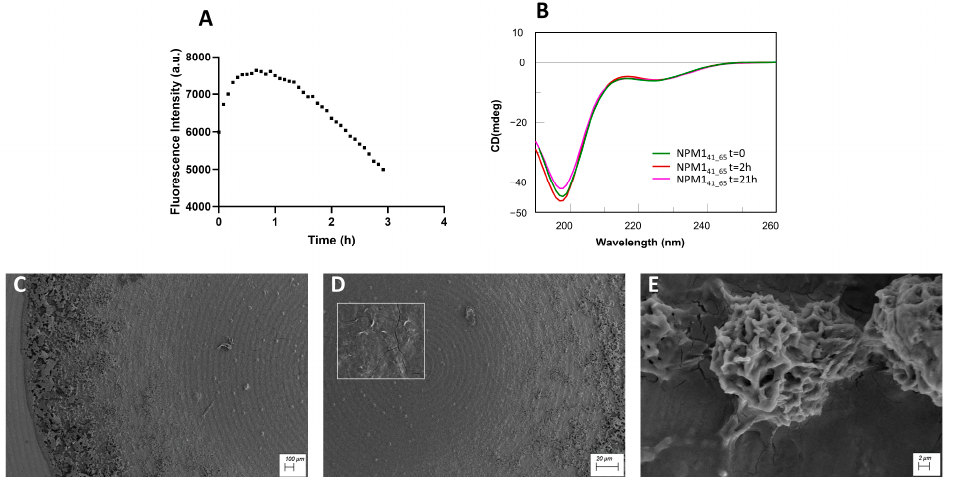
Figure 2. NPM1 41–65 characterization: ( A ) Time course of ThT fluorescence emission intensity; ( B ) CD spectra over time; ( C – E ) SEM micrographs registered at 24 h at 100, 20 and 2 µm.